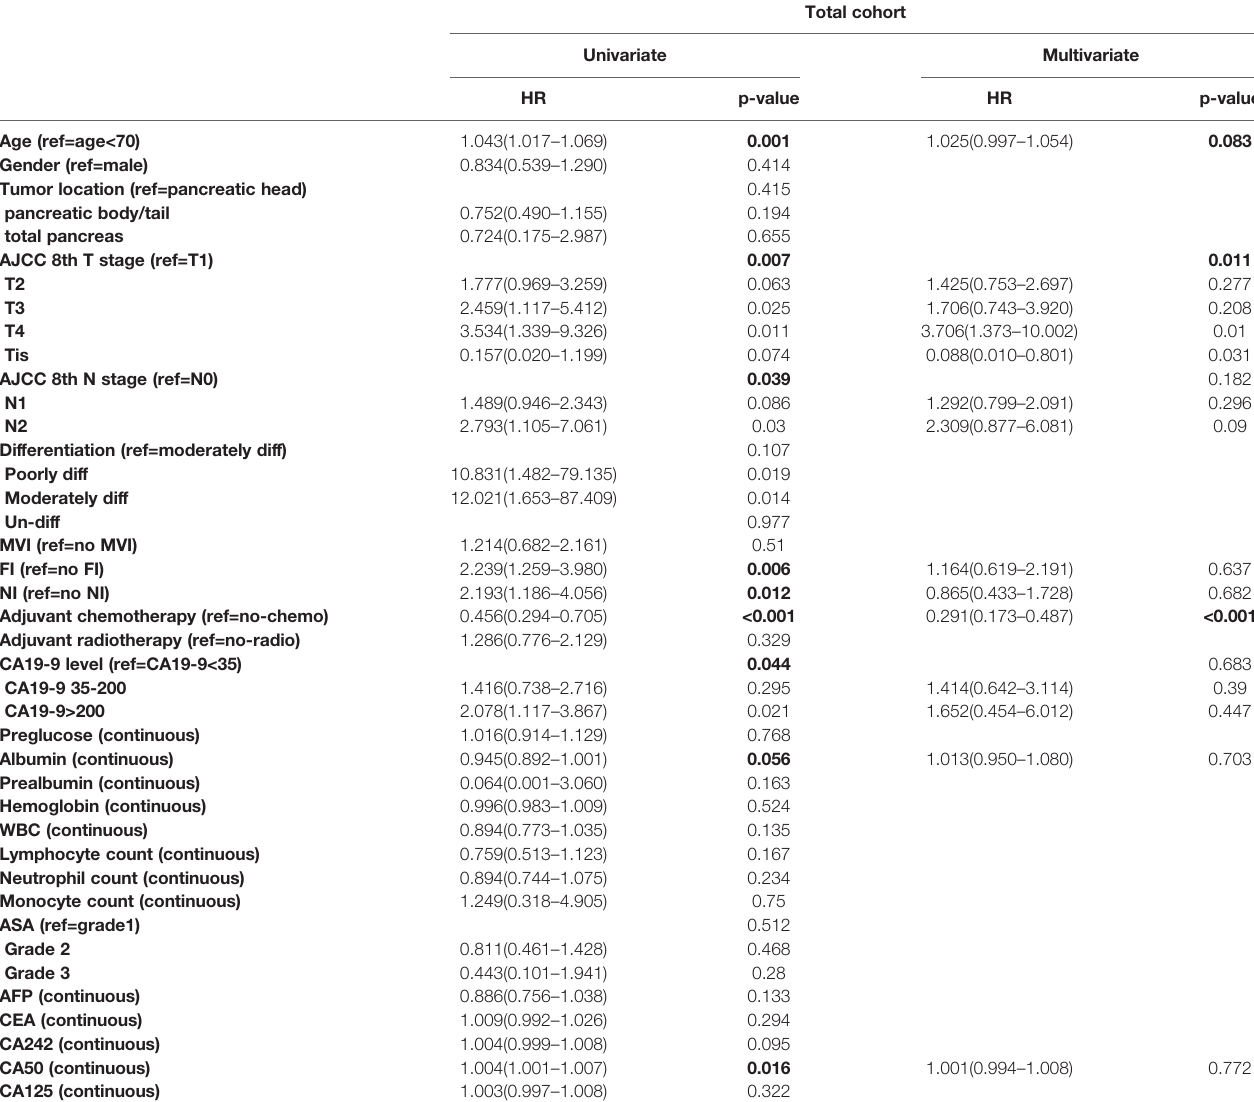
TABLE 3 | Univariate and multivariate Cox regression analysis of the cohort after